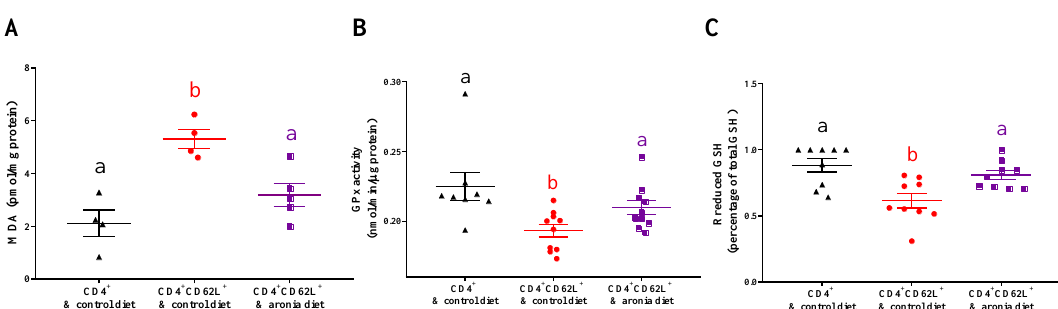
Figure 4. Aronia consumption reduces malondialdehyde (MDA) and prevents depletion of antioxidant enzymes in colon. Splenic CD4 + CD62L + cells from C57BL/6J mice were transferred to Rag1 -/- mice. Mice consumed the AIN-93M diet (colitic control) or aronia-supplemented diet for five weeks. A third group of Rag1 -/- mice received splenic CD4 + cells, consumed AIN-93M diet, and served as the non-colitic control. ( A ) Colon MDA ( n = 4 – 5/group). ( B ) Colon glutathione peroxidase (GPx) activity ( n = 8 – 10/group). ( C ) Colon reduced glutathione (rGSH) ( n = 8 – 10/group). Groups bearing different letters indicate significant differences between treatments ( p < 0.05). Data are means ± SEMs.